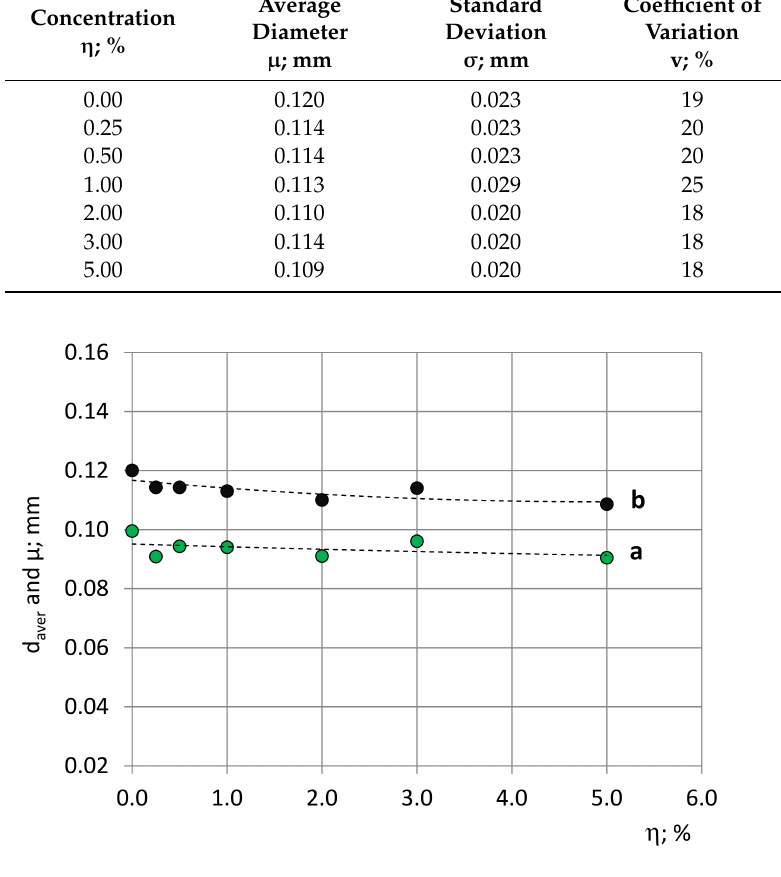
Figure 11. Average diameters of (a) circles d aver (experimental data) and (b) bubbles D aver = µ